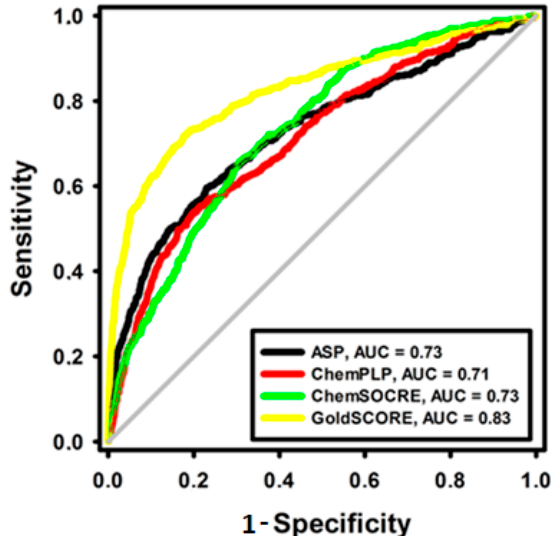
Figure 2. Receiver operating characteristic (ROC) curves of fitness functions implemented in the GOLD program. The diagonal line represents a model that would perform no better than random (AUC = 0.5).